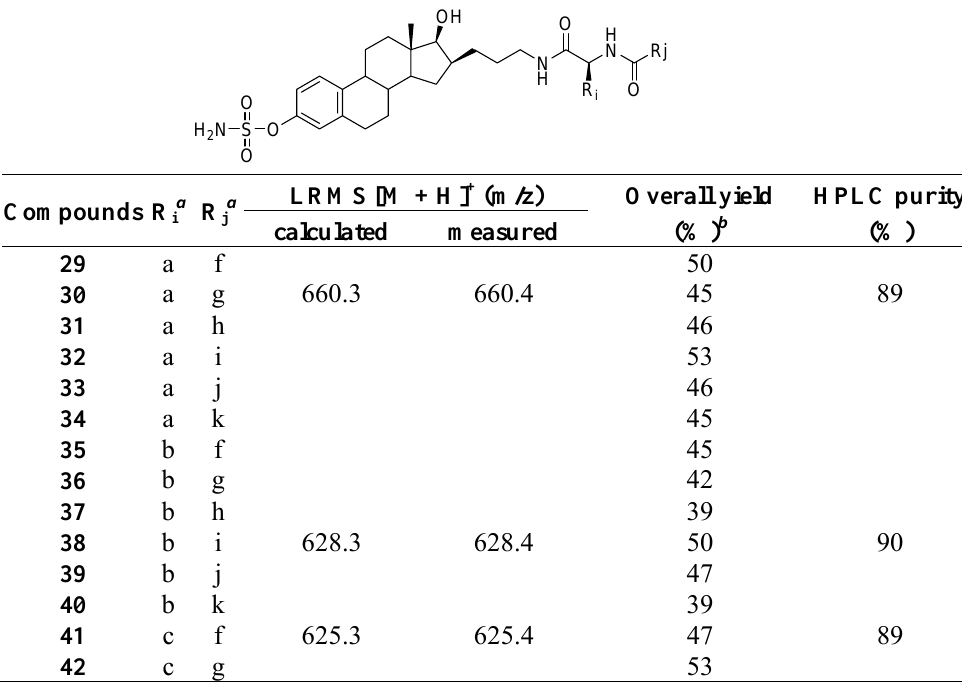
derivatives 29–58 2